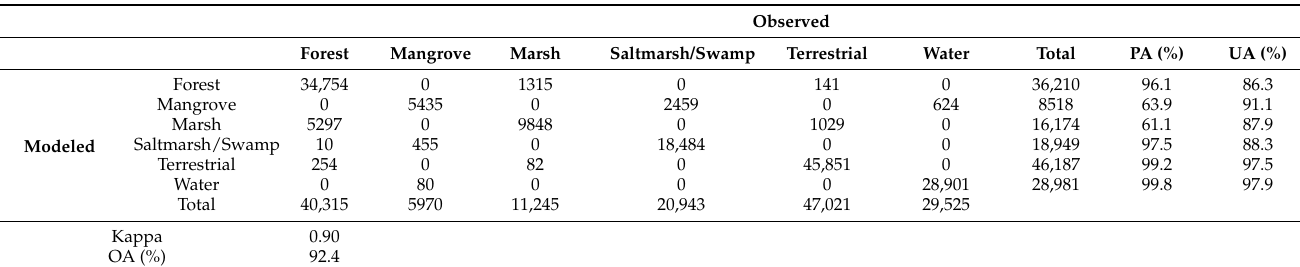
Table 1. A confusion matrix for test points of the Manning wetland classification model together with model performance metrics.